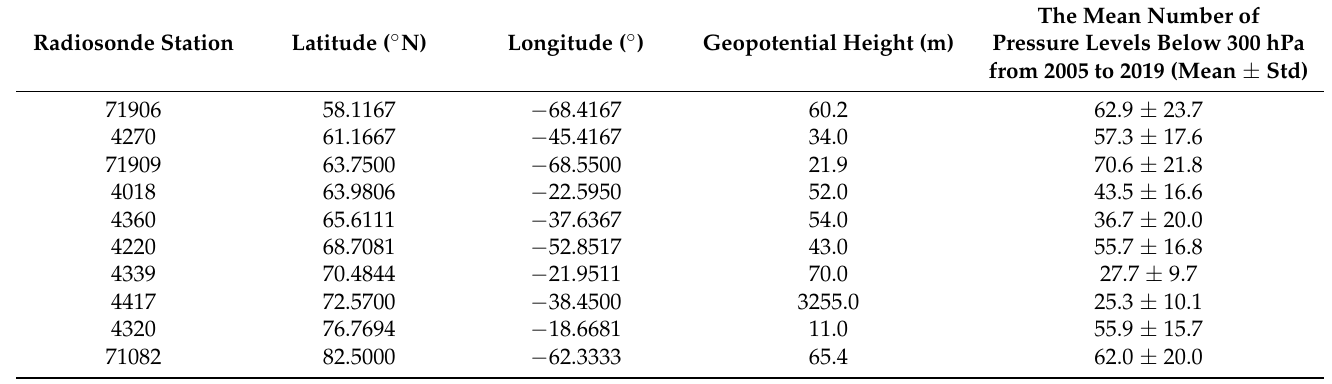
Table 2. Spatial information of 10 radiosonde stations.